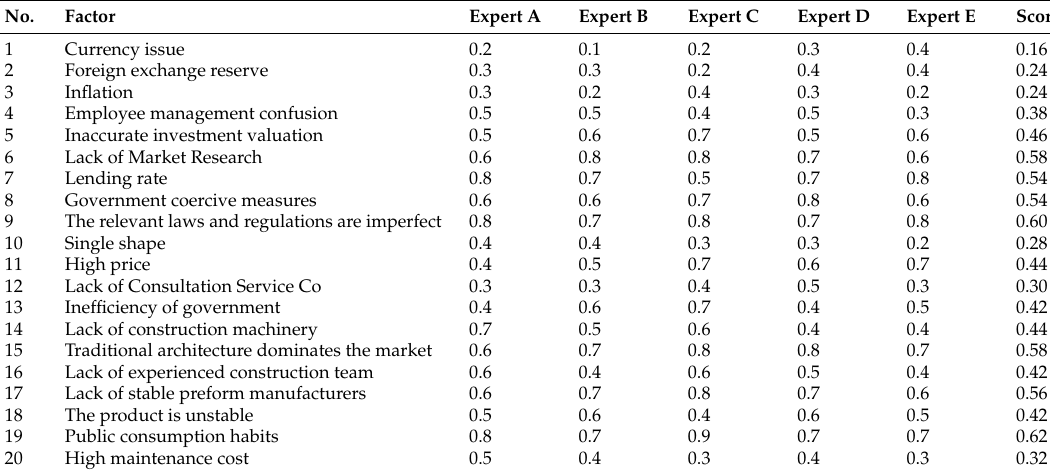
Table 1. Valuation tables for boundary factors.